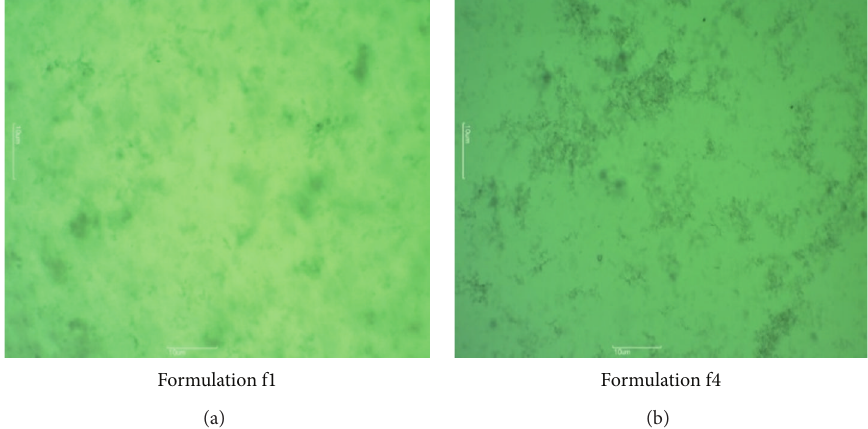
Figure 10: Optical microscopic images of formulation at 10x magnification.